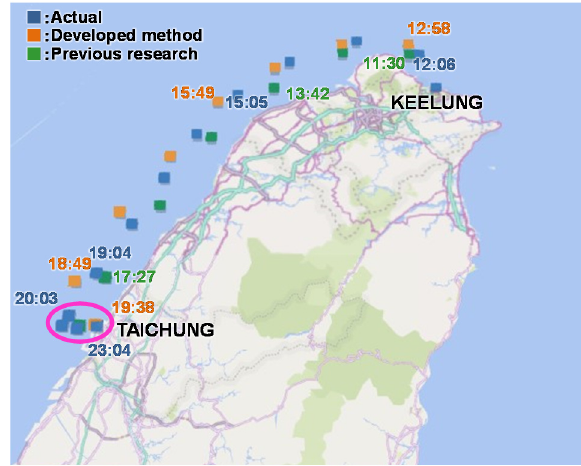
Figure 9. Comparison of ship routes from KEELUNG to TAICHUNG.